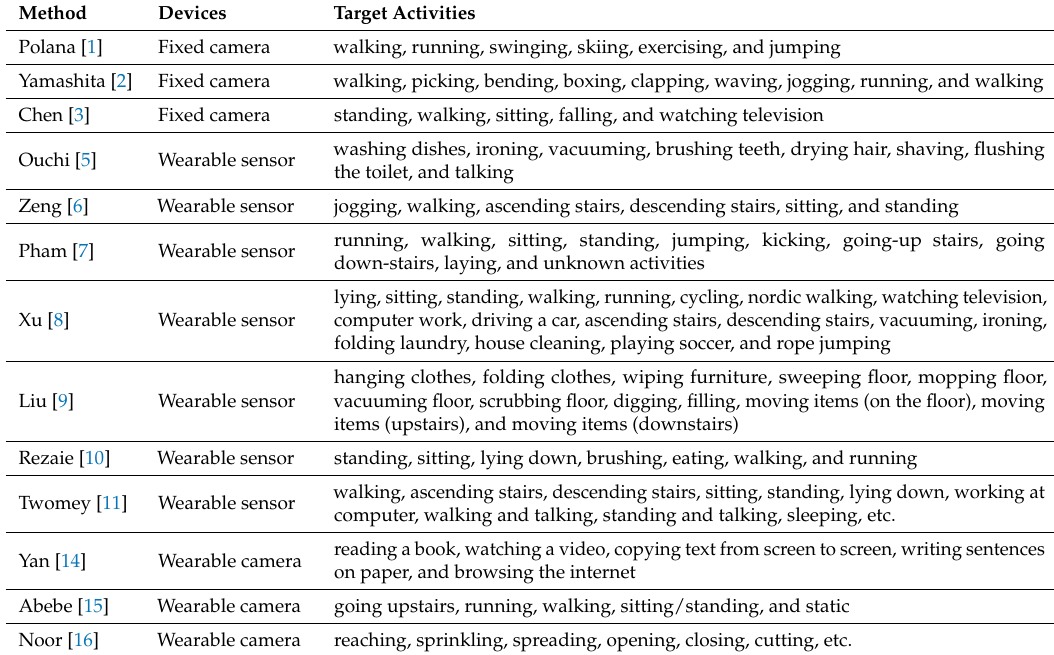
Table 1. Example of target